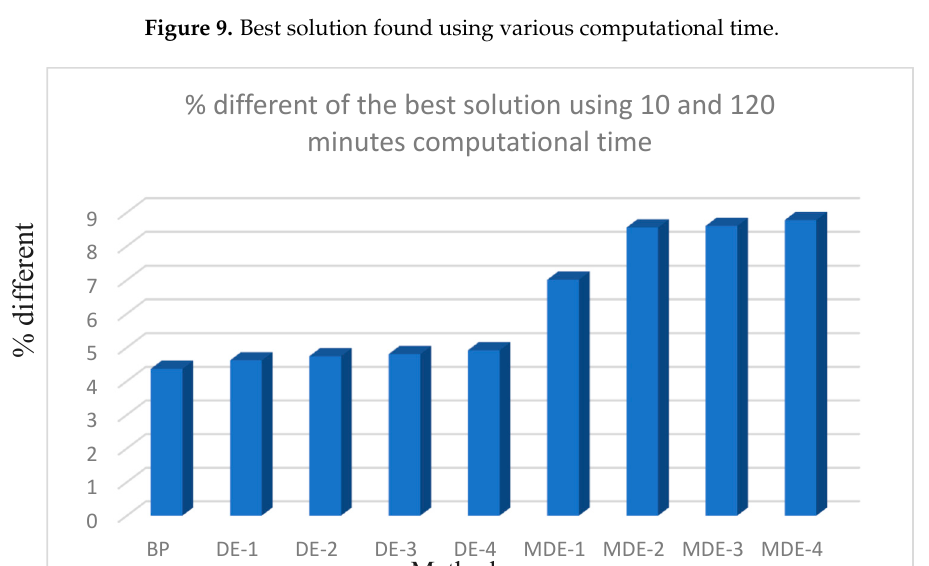
Figure 10. Percent difference in the best solution found using 10 and 120 min of computational time.